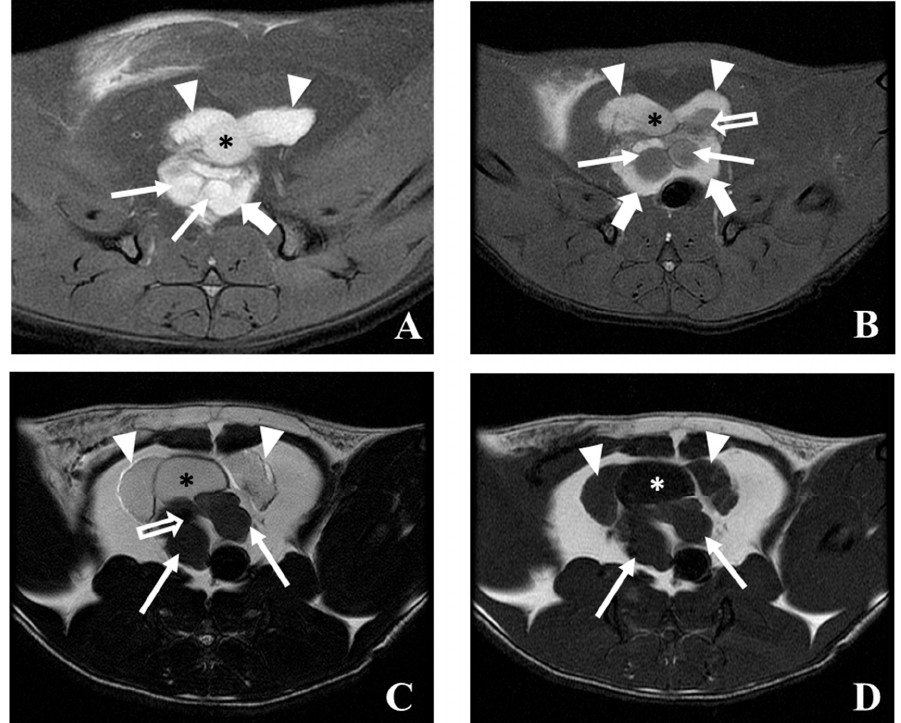
Figure 8. Transverse MRI scan at different levels of rat prostate at 58 weeks of age: ( A ) PD weighted image of a normal animal; ( B ) PD weighted image of a cancer-induced animal (similar level of A); ( C ) T2 weighted image of a cancer-induced animal; ( D ) T1 weighted image of a cancer-induced animal (similar level as ( C )). The urinary bladder (asterisk) is surrounded by the ventral prostate (arrowheads), dorsal prostate (bold arrows) or seminal vesicles (arrows). A prostate and seminal vesicles enlargement is evident in cancer-induced animal, as well some changes with low-intensity signal of some zones of these structures (open arrows). In images ( A ) and ( B ), it is possible to observe the transition between the seminal vesicles and the dorsal prostate, standing out the loss of signal intensity of seminal vesicle in prostate cancer-induced animal.